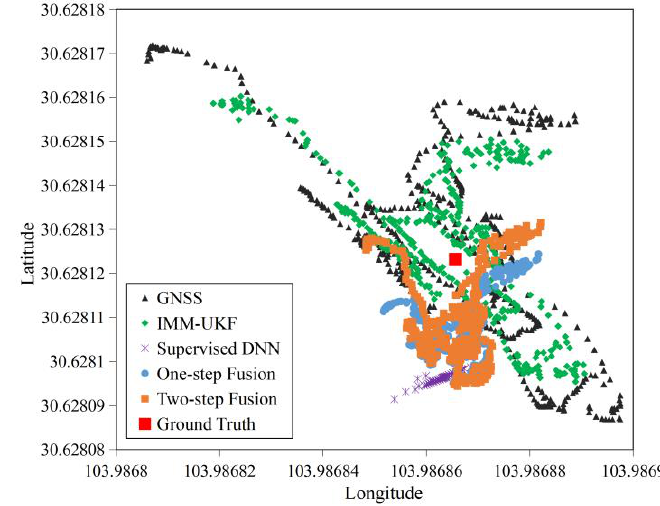
Figure 10. Location distributions in Scenario 2.